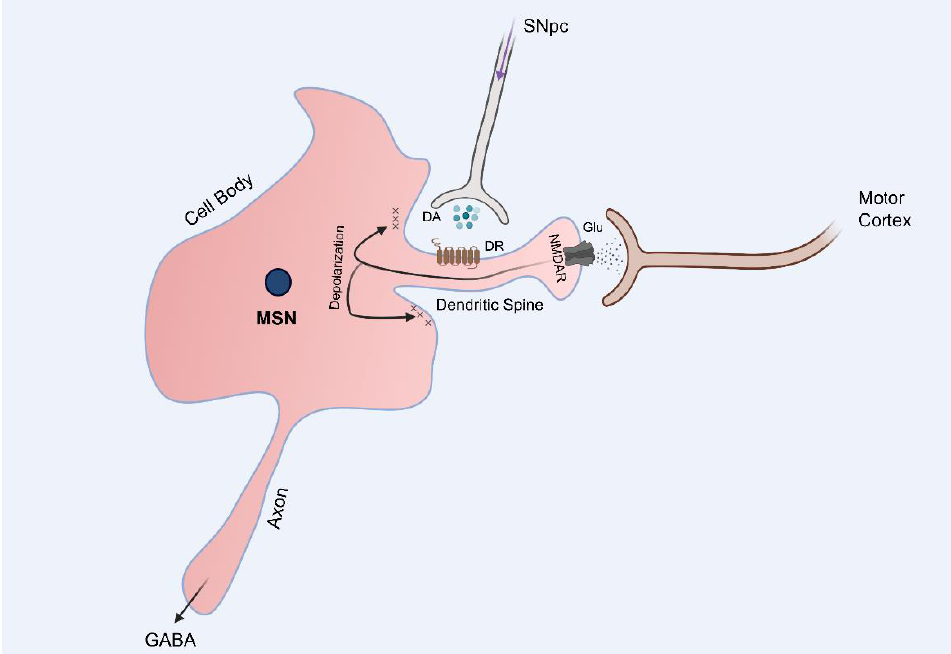
Figure 2. Roles of the nigrostriatal pathway in the regulation of the basal ganglia pathway. Medium spiny neurons (MSNs) in the putamen receive stimulatory input through the cortico-striatal glutamatergic neurons. They also receive dopaminergic input through nigrostriatal DAergic neurons. DA stimulates the direct pathway by acting on the D 1 Rs expressed on the MSNs that project to the GPi but inhibits the indirect pathway by acting on the D 2 Rs expressed on the MSNs that project to the GPe. Thus, degeneration of DAergic neurons originating from the SN results in an under-stimulation of the direct pathway and under-inhibition of the indirect pathway, resulting in problems with purposeful movement. DR, dopamine receptor; Glu, glutamine; NMDAR, NMDA receptor. Figures created with https://biorender.com/ (accessed on 13 April 2021).